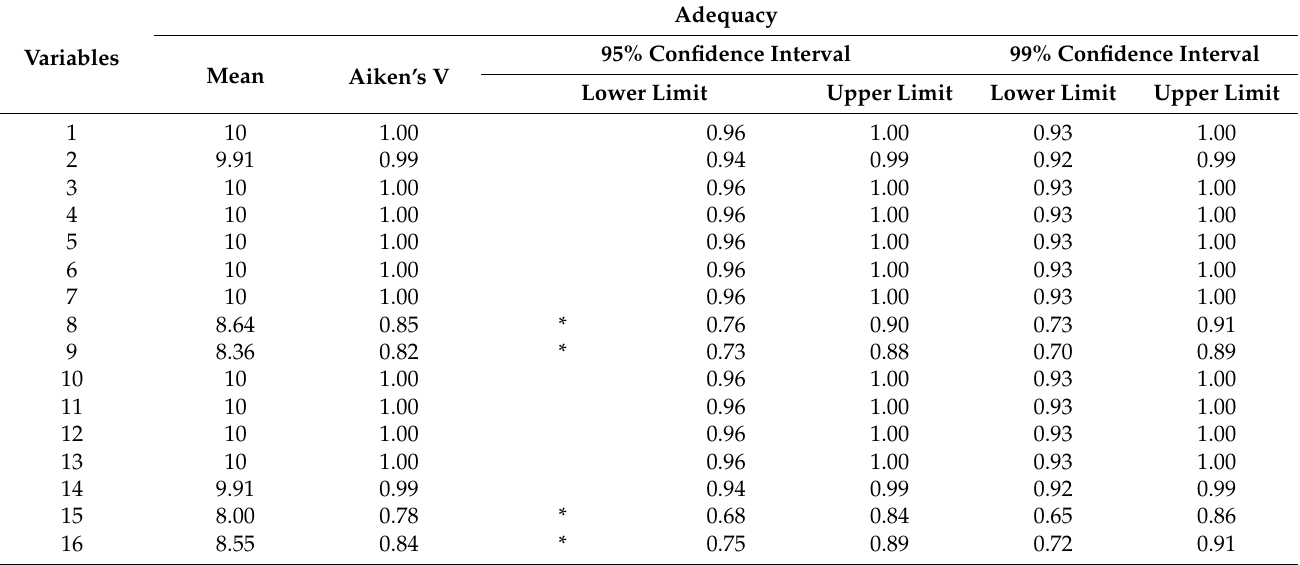
Table 4. Results of Aiken’s V coefficient and confidence intervals